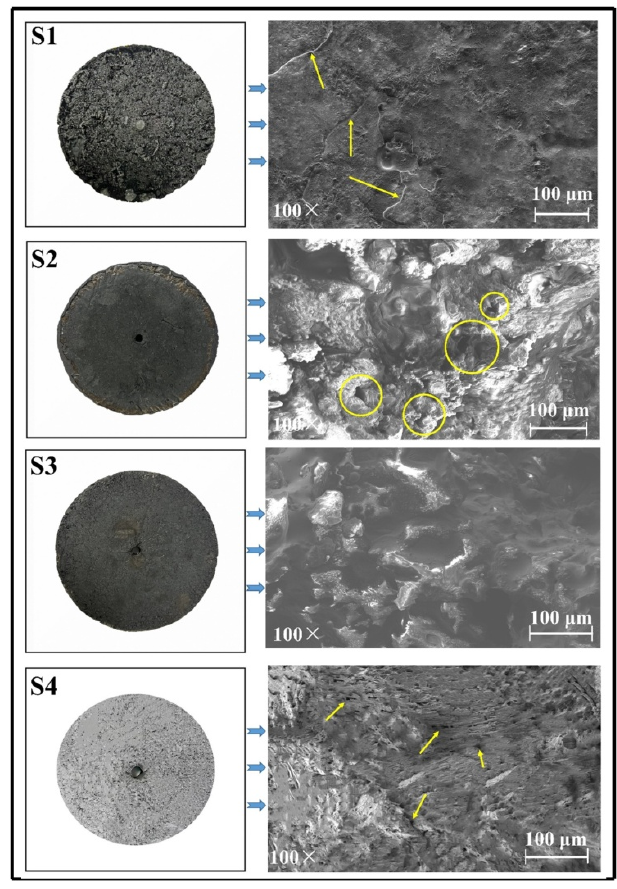
Figure 4. SEM micrographs of the various grinding wheels.